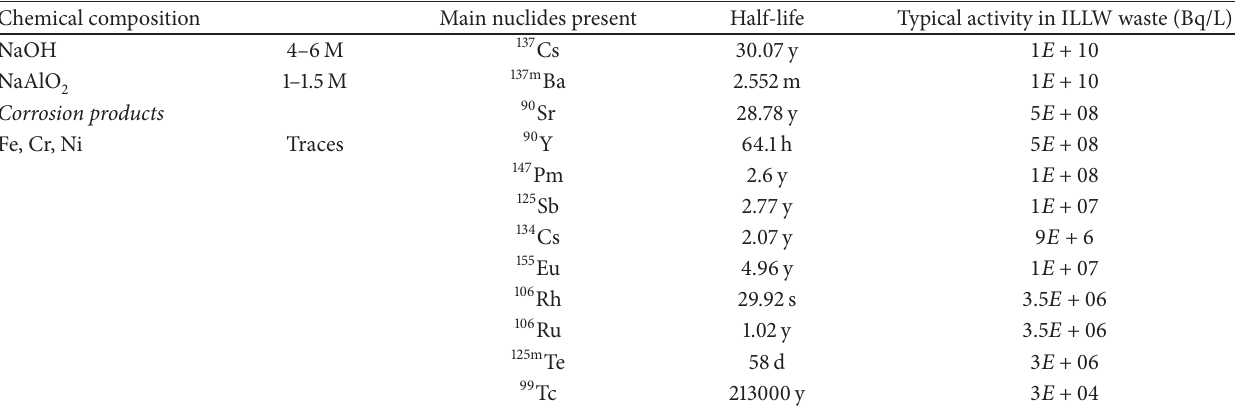
Table 1: Typical ILLW from alkaline-route 99 Mo production at ANSTO > 10 years after production.